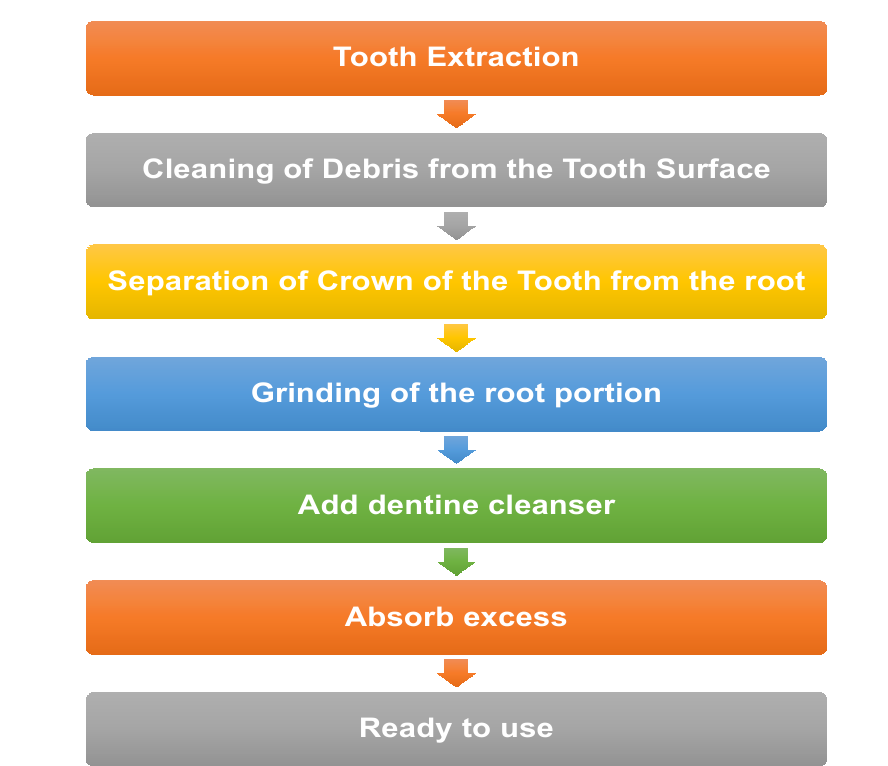
Figure 1. Flow chart showing method of preparation of AUTO-BG.